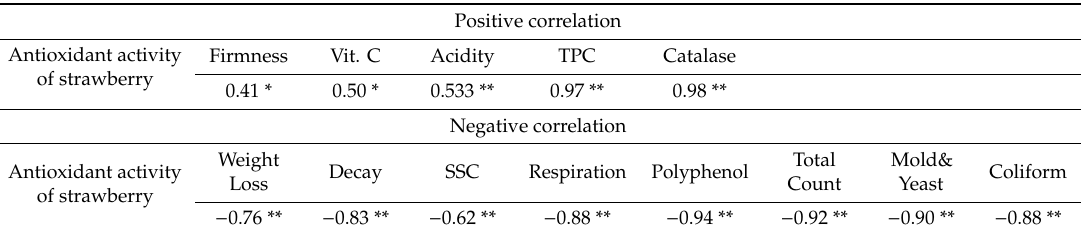
Table 4. Correlation study between total antioxidant activity of treated fruits and physiochemical and microbial properties of strawberry